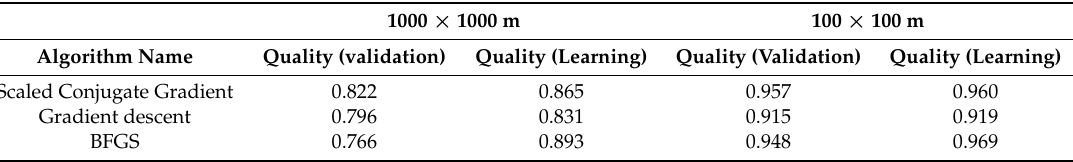
Table 2. Average quality of the validation sample determined for the learning neural networks with the use of each of the three algorithms applied, in two sizes of primary field.